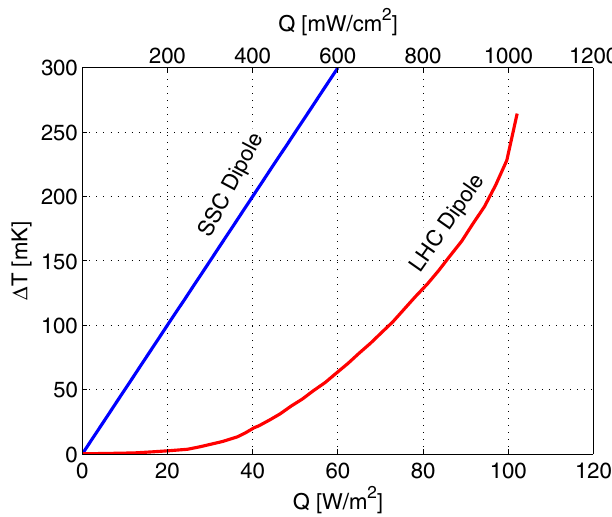
FIG. 4. (Color) Heat transfer curves at T (cid:4) 1 : 8 K measured by Meuris during LHC main dipole insulation